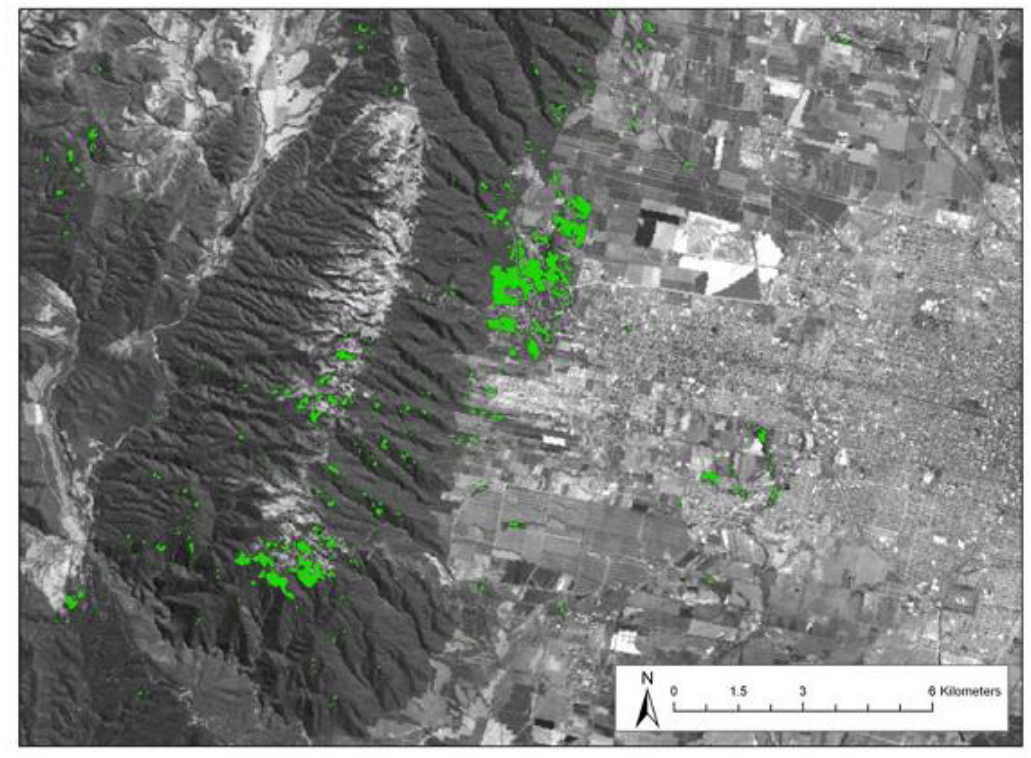
Fig. 5. Distribution of Ligustrum lucidus monodominant stands in 2001 (in green) in the southern sector of the study